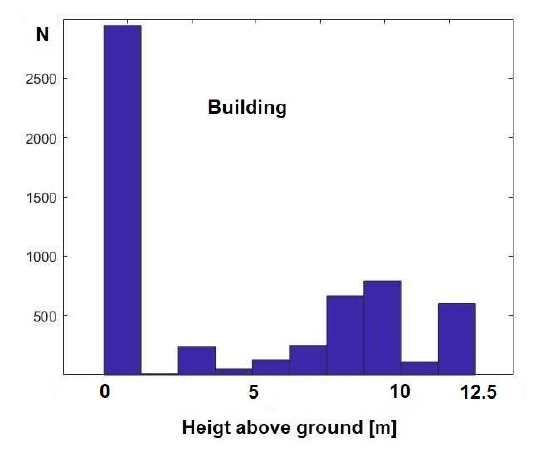
Figure 8. Histogram of the number of points present within a façade tile of 50x50cm (see black arrow in Figure 5)